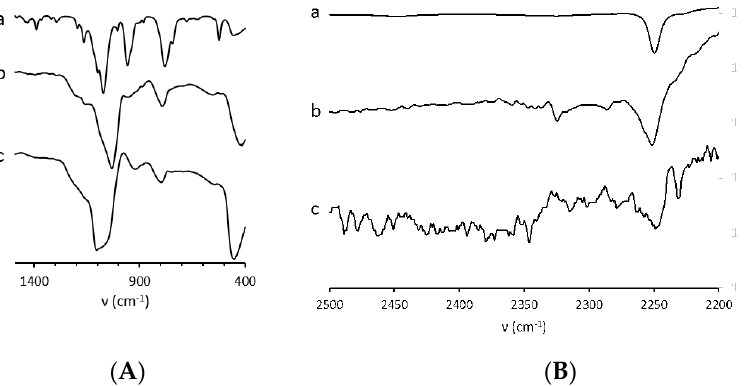
Figure 8. Difference spectra ( SiO 2 @CN - SiO 2 ) on two specific ranges, i.e 400-1500 cm −1 ( A ) and 2200-2500 cm −1 ( B ). The spectrum of TESPN is indicated in (a), (b) SiO 2 produced in MeOH, (c) with SiO 2 produced in EtOH.